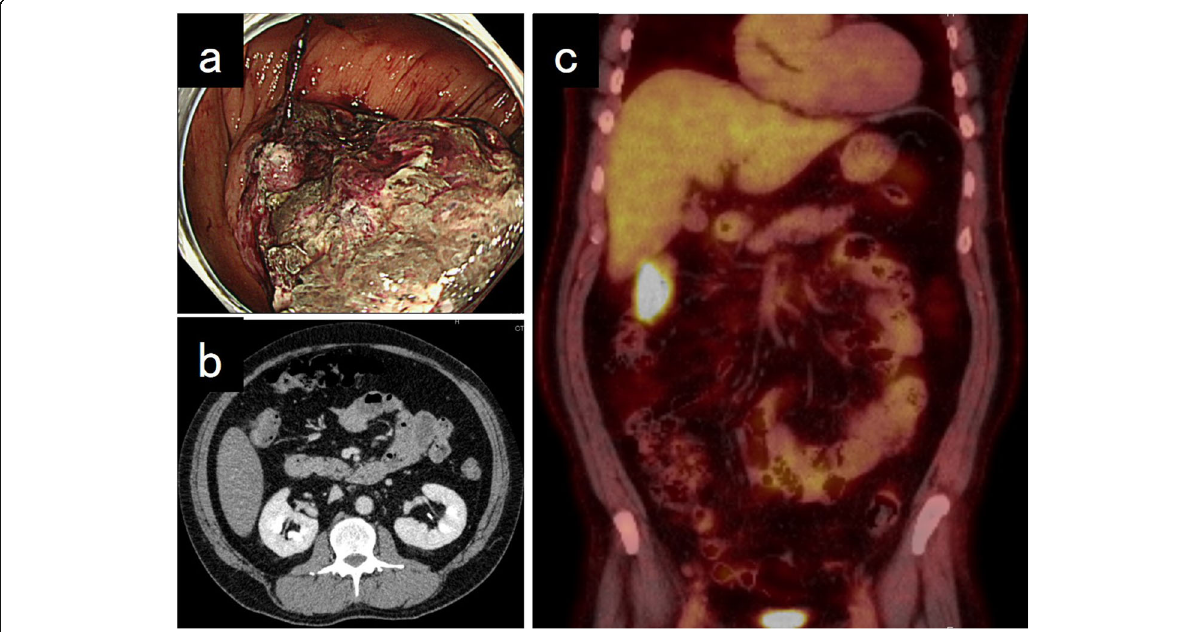
Fig. 1 Image of the transverse colon cancer. Colonoscopy showed a type 3 tumor with necrotic tissue ( a ). Contrast-enhanced CT did not indicate colon cancer ( b ). Positron emission tomography showed an accumulation of 18 F-fluorodeoxyglucose in the colon ( c